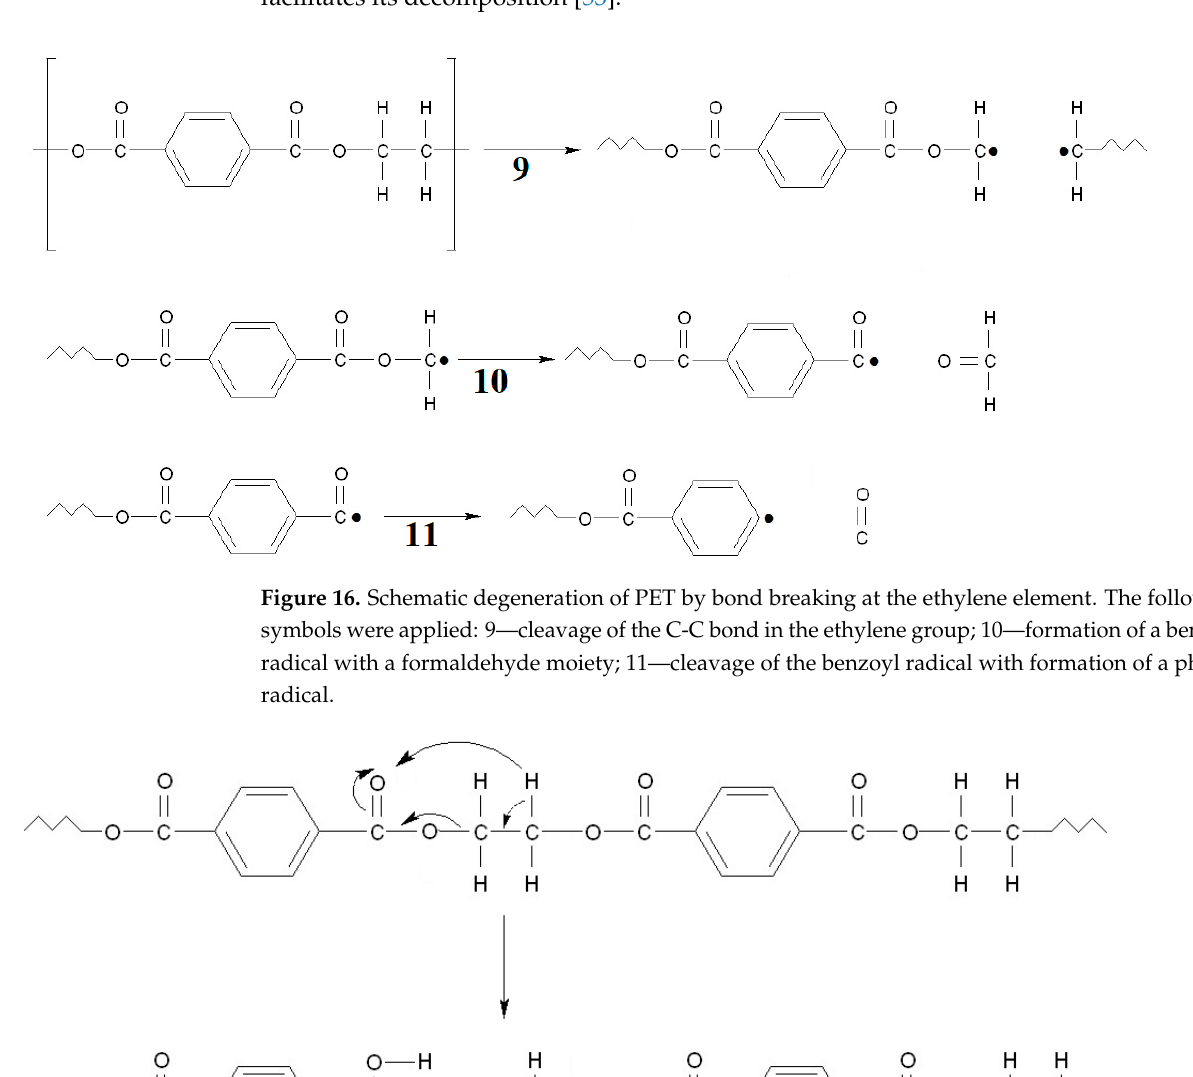
Figure 17. Schematic PET decomposition according to Norrish type reaction II. As a result, during subsequent reactions, terephthalic acid and derivatives containing vinyl group are formed.